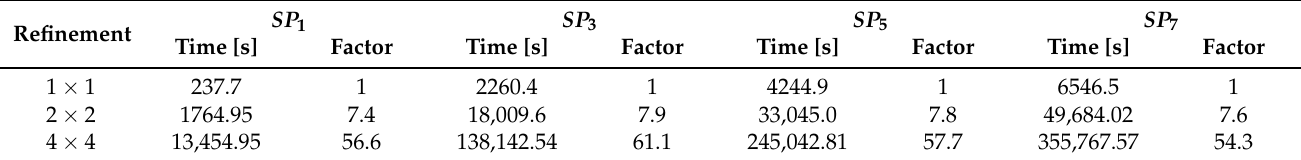
Table 10. Comparison of computational times for different